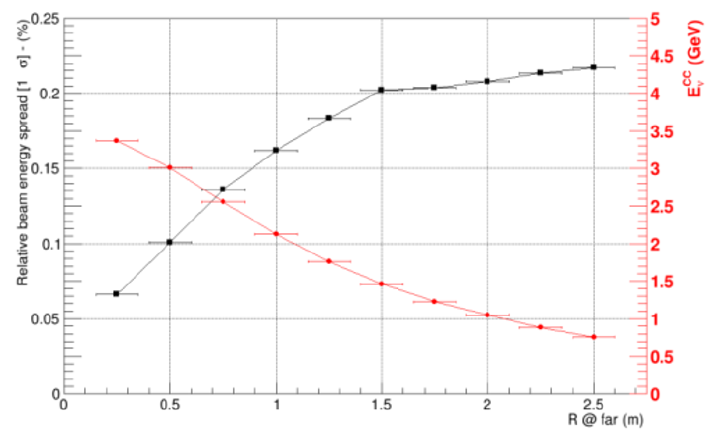
Figure 15. Black points: neutrino energy resolution, corresponding to the 1 σ beam width, versus the distance of the ν µ interaction vertex to the beam axis (“R @ far”). Red points: mean neutrino energy (in GeV) versus R @ far.